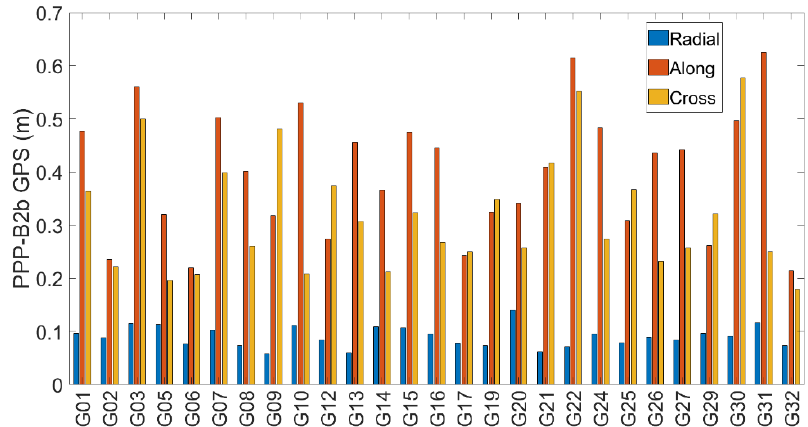
Figure 3. RMS values of BDS-3 orbit errors for the CNES products.